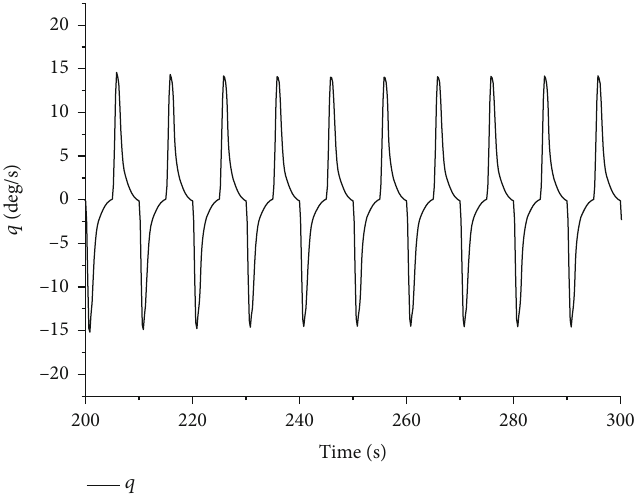
Figure 26: Pitch angular rate with attitude control.